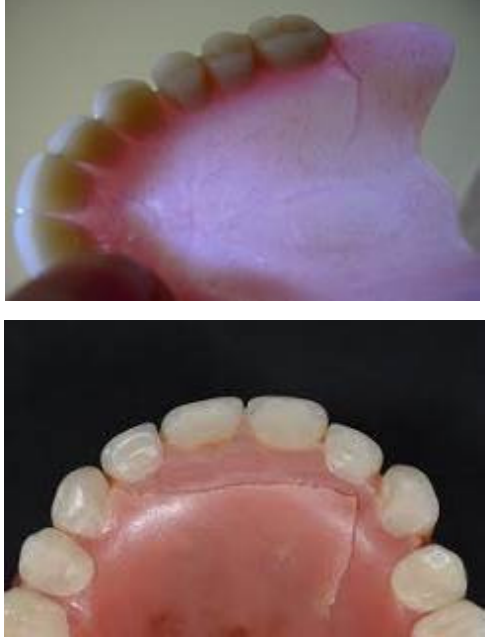
Fig. 2. Show the Fatigue Fracture in the Prosthetic